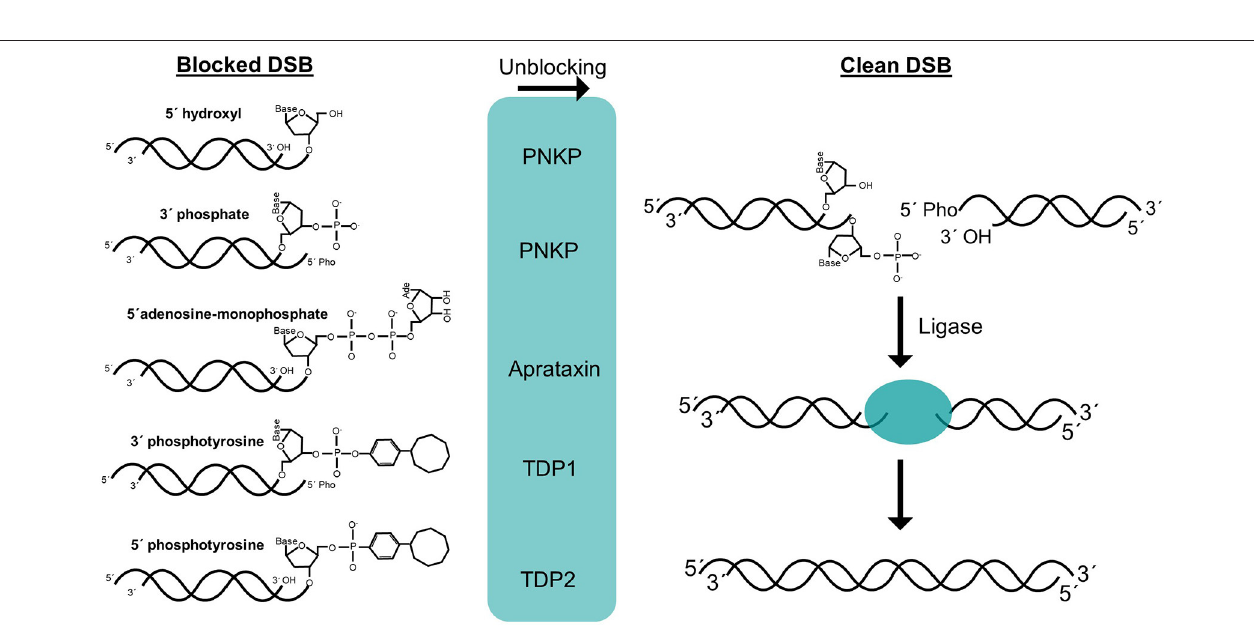
FIGURE 1 | Unblocking and processing of DSBs. Unblocking pathways directly convert ends into 5 ′ -phospahte and 3 ′ -hydroxyl but the nucleotide sequence remains intact, promoting error-free repair ( left ). Processing can also facilitate blocked DSBs repair removing aberrant structures from DNA ends by nucleotide trimming ( right ). This pathway can lead to error-prone repair when non-templated repair pathways such as NHEJ or MMEJ are used. 5 ′ blocks are depicted but similar situations could be generated on 3 ′ ends.